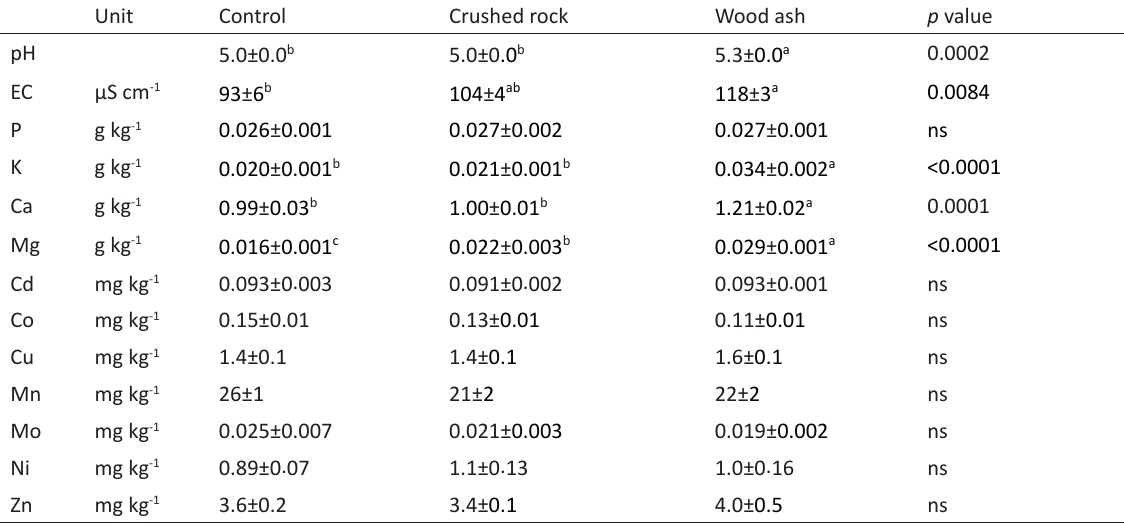
Table 3. Soil pH in 0.01M CaCl , electrical conductivity (EC) and EDTA-extractable element concentrations 14 months after amendment 2 with crushed rock or wood ash and in the non-amended control. Data is given as Least-Squares Means ± SEM. Unit Control Crushed rock Wood